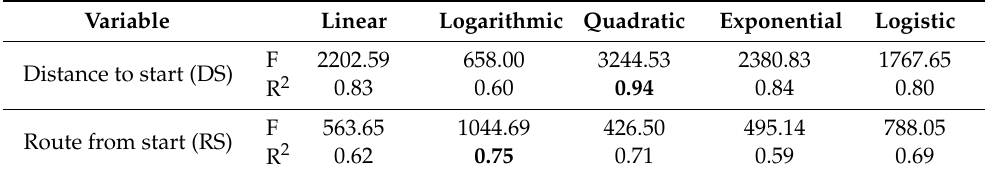
The table shows the F value and R 2 value for the models.